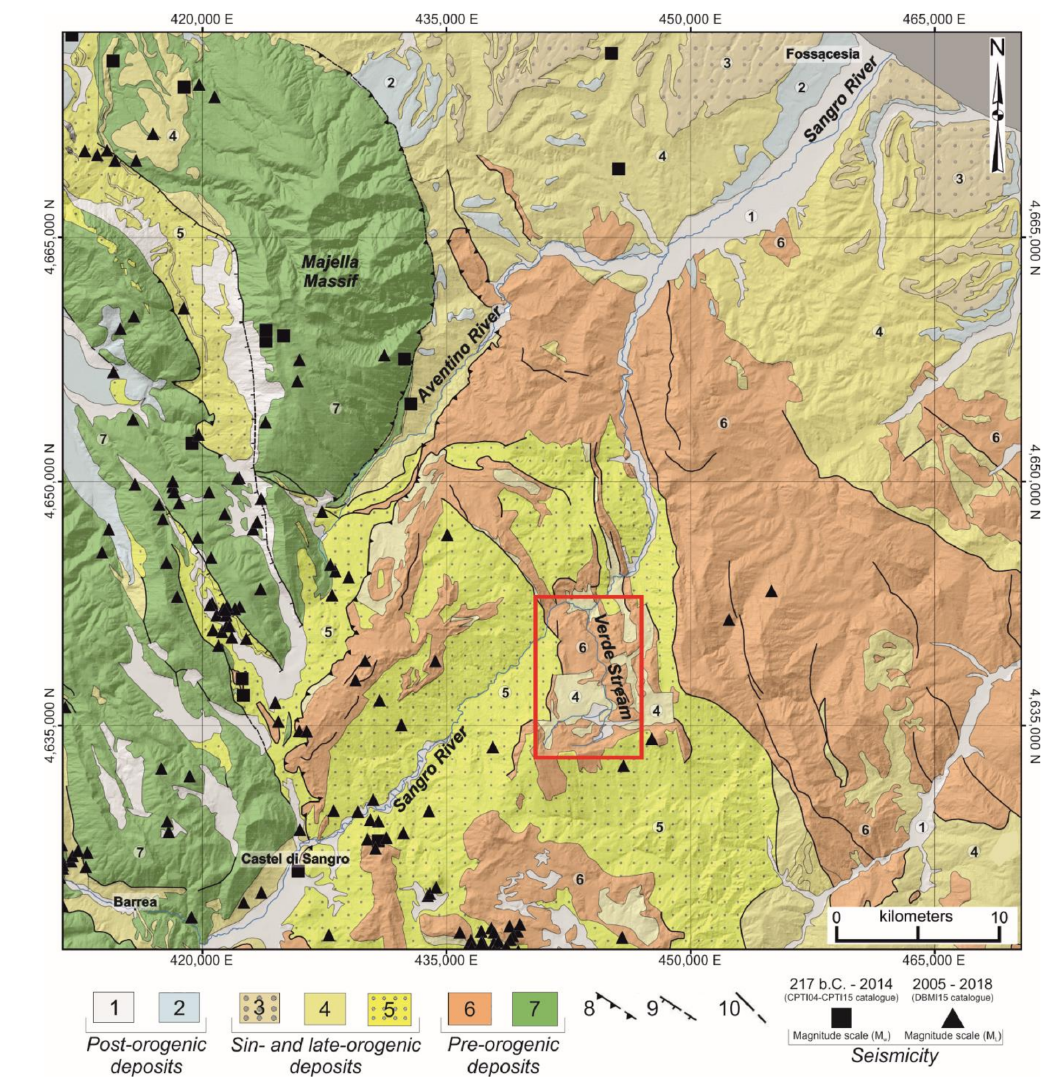
Figure 2. Geological scheme of southeastern Abruzzo (modified from [2]). Legend: post-orogenic Quaternary continental deposits, (1) fluvial deposits (Holocene), (2) terraced fluvial and alluvial fan deposits (Middle-Late Pleistocene); sin- and late-orogenic terrigenous deposits, (3) marine to continental transitional sequences (Early Pleistocene), (4) hemipelagic sequences with conglomerate levels (Late Pliocene–Early Pleistocene), (5) turbiditic foredeep sequences (Late Miocene–Early Pliocene); pre-orogenic carbonate, marly and clayey deposits, (6) Molise pelagic sequences (Oligocene–Miocene), (7) carbonate platform, slope and pelagic basin sequences (Jurassic–Miocene); (8) major thrust (dashed if buried); (9) major normal fault (dashed if buried); (10) major fault with strike-slip or reverse component (dashed if buried); seismicity, CPTI04 [54]-CPTI15 [7] catalogue (black square); DBMI15 [55] catalogue (black triangle). In blue: the drainage network; the red box frames the drainage basin object of this